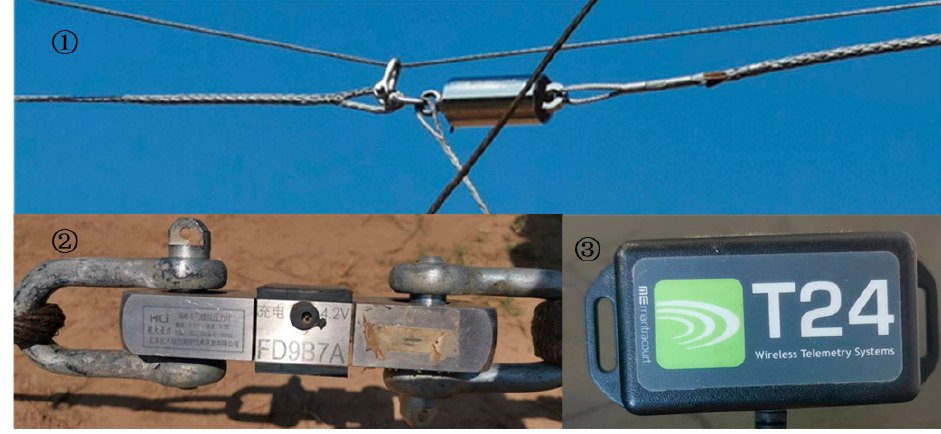
Figure 10. Some experiment devices ( ① release device, ② tension sensor, ③ wireless communication module). The wire was tensioned by a force of 7890 N, which is 10% of its breaking force. The